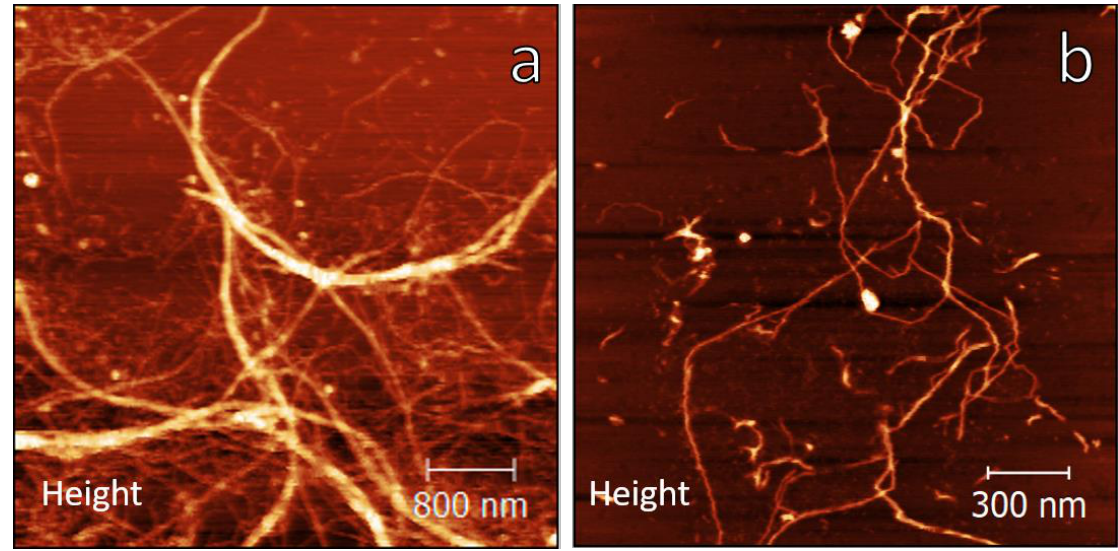
Figure 1. AFM height images of cocoa shell nanocellulose for 5 × 5 µ m ( a ), and 2 × 2 µ m ( b ) areas.